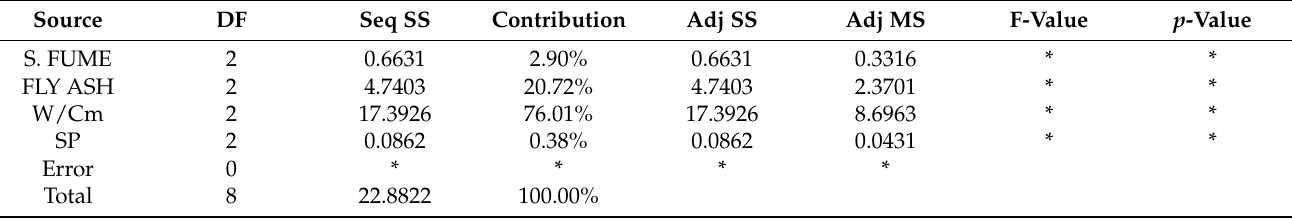
Table 8. ANOVA for FRC compressive strength at 28 days.